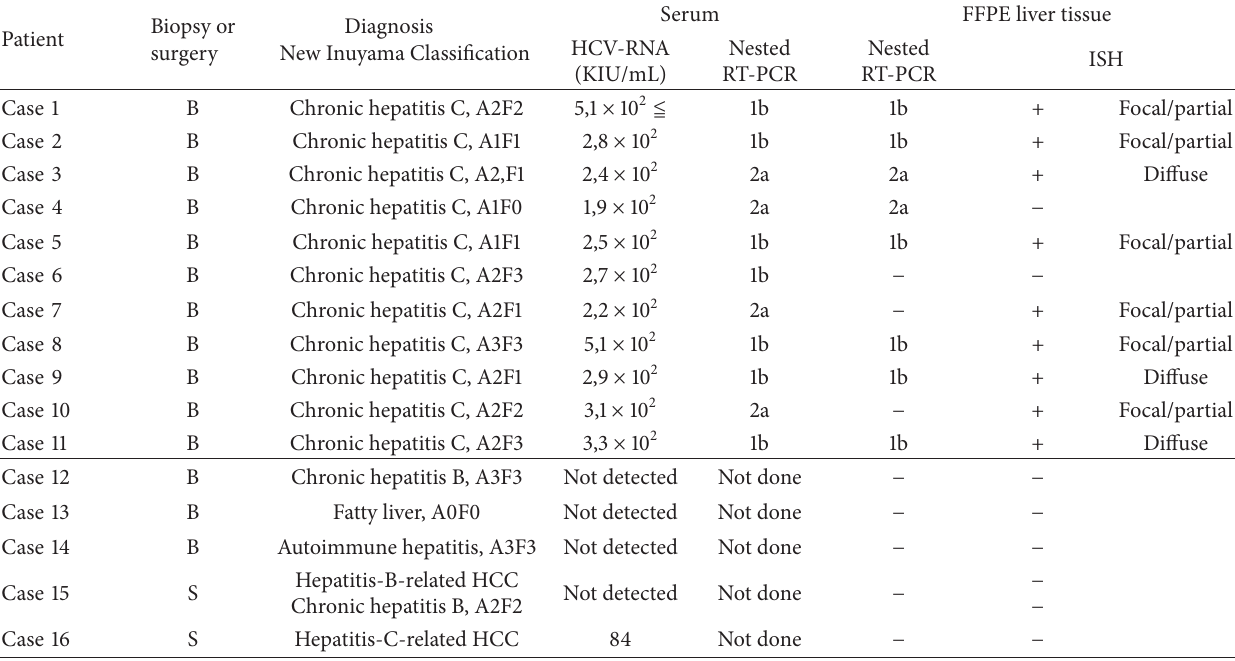
Table 1: HCV-RNA demonstration with LNA-based ISH and nested RT-PCR in FFPE human liver